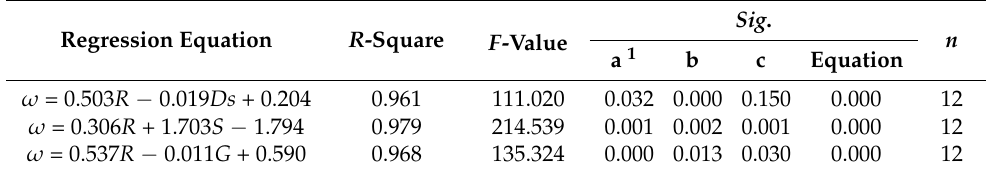
Sig . n a 1 b c Equation